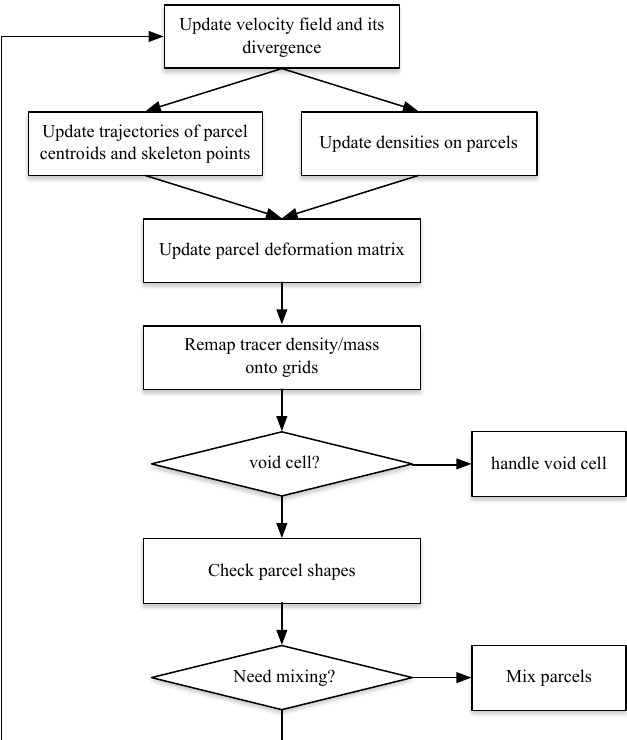
Figure 5. The workflow of